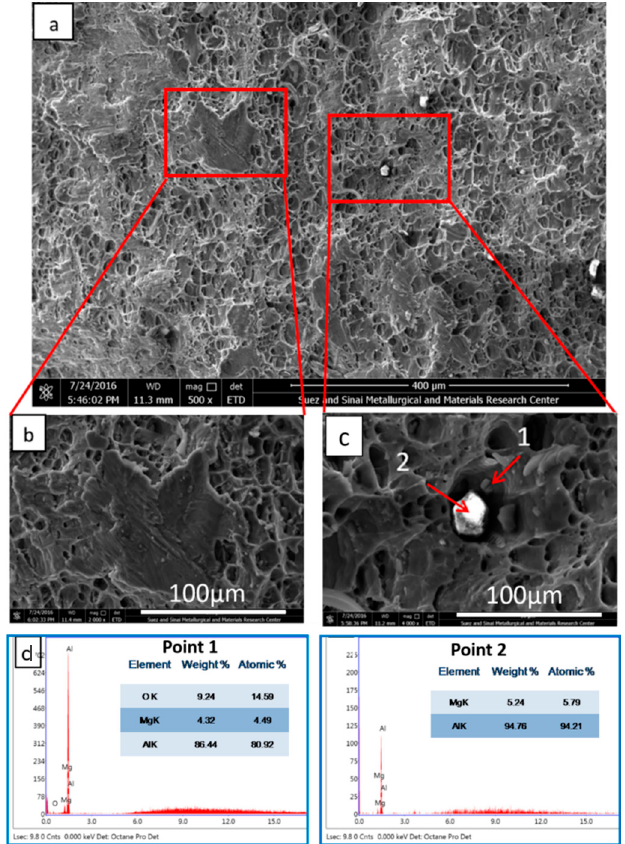
Figure 13. SEM micrographs of the fracture surface of tensile test sample of AA5083/AA5754 joint at 400 rpm–60 mm/min, ( a ) mixed fracture mode ( b ) brittle fracture features, ( c ) ductile fracture features, ( d ) EDX spot analysis of the points 1 and 2.